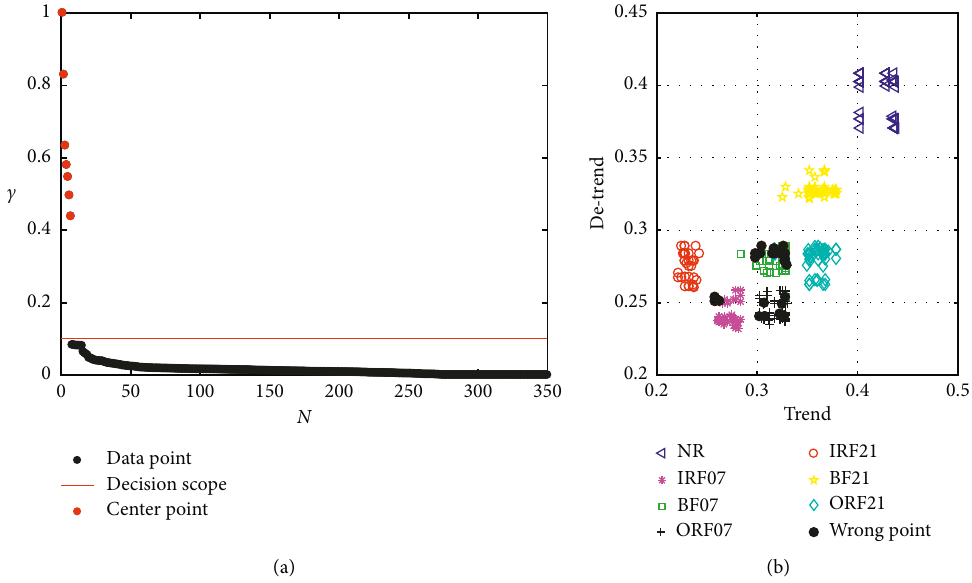
Figure 11: The clustering result of the rolling bearing by using the EEMD-FDE-DPC: (a) decision graph and (b) clustering